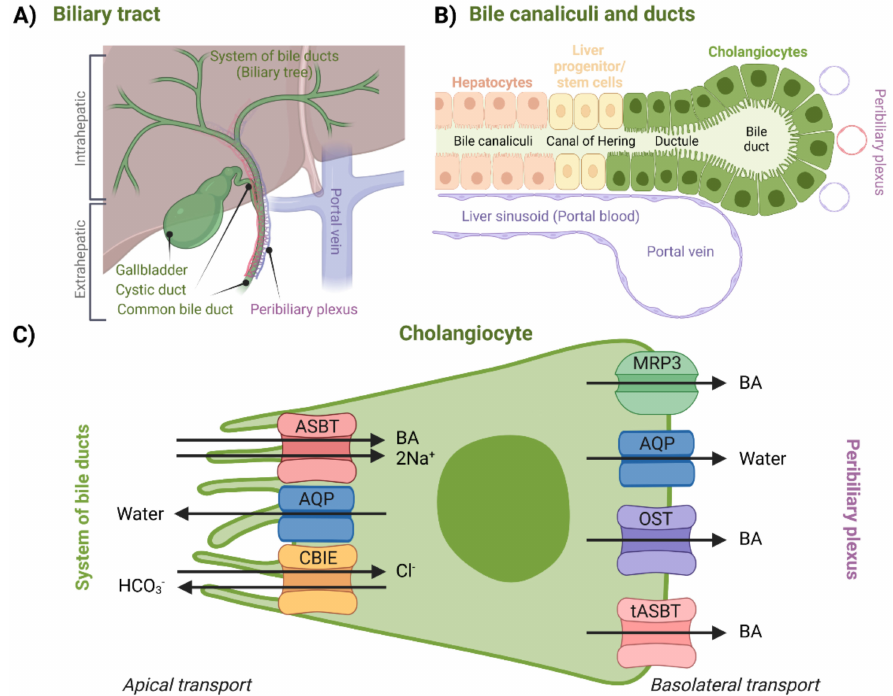
Figure 5. Illustration of: ( A ) biliary tract, ( B ) bile canaliculi and ducts, and ( C ) transport proteins and processes described to be taking place in cholangiocytes. Created with